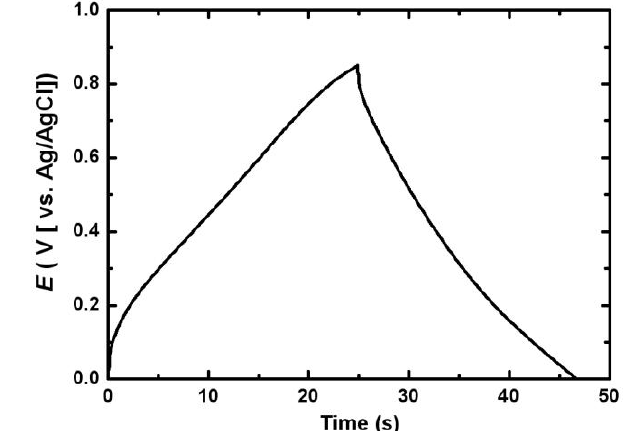
Figure 6. Charge-discharge curve of the electrodeposited Mn-Ni oxide electrode in 0.5 M Na SO 2 4